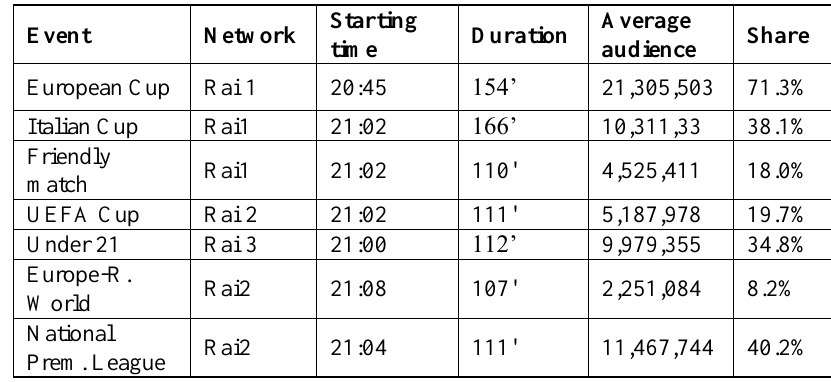
Figure 12: Football TV Audiences in